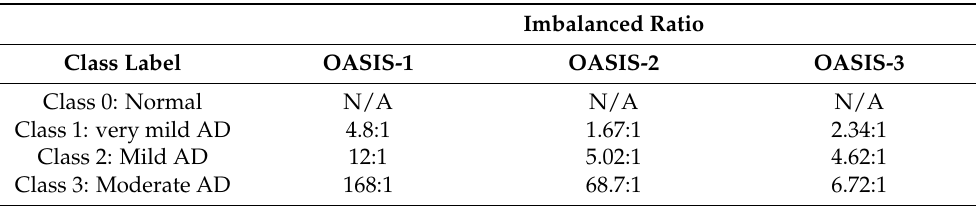
Table 2. Imbalanced ratios across different classes of OASIS-1, OASIS-2, and OASIS-3.